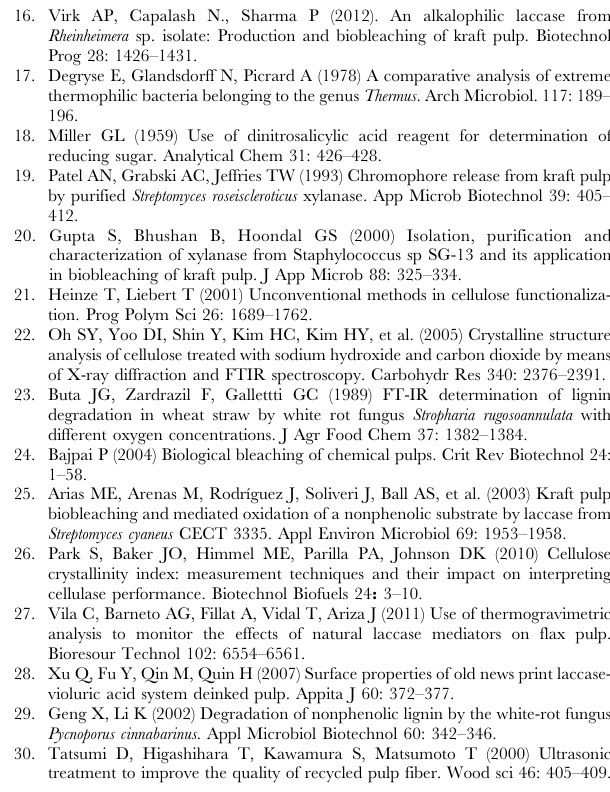
Figure S1 3D graph of combined effects of (A) Time and Enzyme dose (B) Time and pH (C) Enzyme dose and pH, on brightness when third factor was kept constant and its optimal level for xylanase treatment.